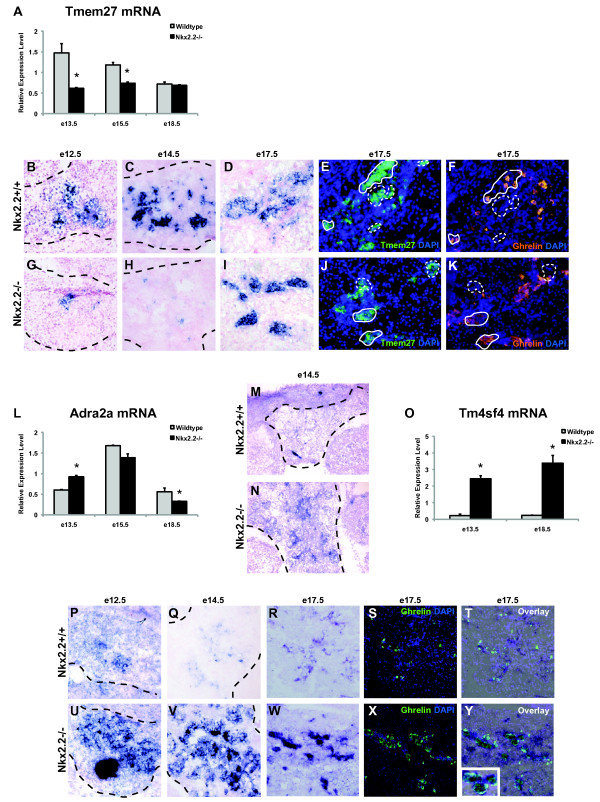
Loss of Nkx2.2 affects expression of known endocrine transmembrane proteins, Tmem27, Adra2a, and a novel tetraspanin, Tm4sf4. qRTPCR of (A) Tmem27, (L) Adra2a, and (O) Tm4sf4 mRNA transcript levels were determined at e13.5, e15.5, and e18.5 and all genes compared wild type (grey bars) and Nkx2.2-/- pancreata (black bars). In situ hybridization comparing wild type and Nkx2.2-/- pancreas at e12.5, e14.5, and e17.5 of Tmem27 (B, C, D, G, H, and I), e14.5 of Adra2a (M and N), and e12.5, e14.5, and e17.5 of Tm4sf4 (P, Q, R, U, V, and W). Error bars represent SEM and asterisks denote statistical significance < 0.05. To assess co-expression, immunofluoresence staining of Tmem27 (E and J;green) and Ghrelin (F and K;copper) was performed on adjacent sections. Similarly, adjacent sections to the Tm4sf4 in situ hybridizations were stained for ghrelin (T and Y;green) and overlayed (T and Y: inset 2× zoom). DAPI (blue) indicates nuclei. Magnification 20× for e12.5, e14.5, R, S, T, W, X, Y, while 40× for E, F, J, and K. Large black dashed lines outline the pancreas at e12.5 and e14.5. Small solid white lines outline Tmem27 and ghrelin co-expression areas. Dashed white lines outline Tmem27+ cells that do not co-express ghrelin.